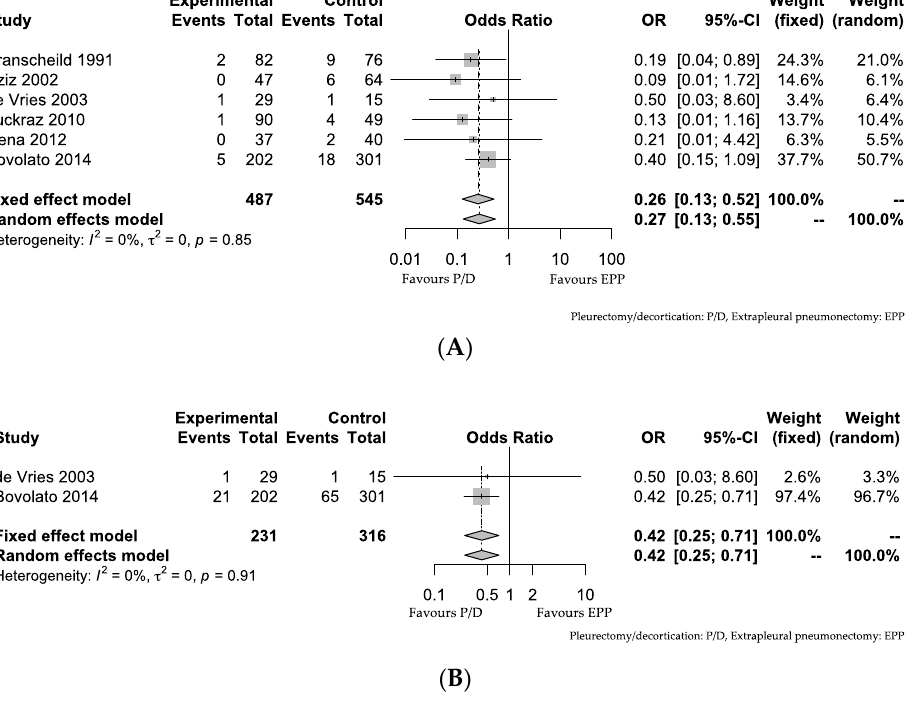
Figure 4. ( A ) Comparison of postoperative mortalities of P / D and EPP. Forest plot of the odds ratio (OR) of the mortality after pleurectomy / decortication (P / D) vs. extrapleural pneumonectomy (EPP) in surgery for malignant pleural mesothelioma (MPM). ( B ) Comparison of postoperative morbidities of P / D and EPP. Forest plot of the OR of the morbidity after P / D vs. EPP in surgery for MPM. The estimate of the OR of each study corresponds to the middle of the square, and the horizontal line shows the 95% confidence interval (CI). On each line, the event number as a fraction of the total number treated is shown for both treatment groups. For each subgroup, the sum of the statistics, along with the summary OR, is represented by a solid diamond. The result of a test of heterogeneity between the trials within a subgroup are given below the summary statistics. Table 3. A summary of the median survival time of pleurectomy / decortication vs. extrapleural